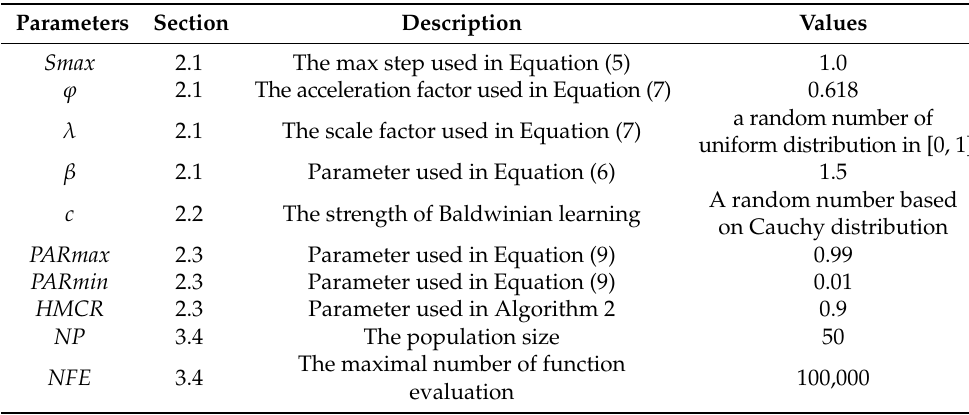
Table 1. Settings of parameters of